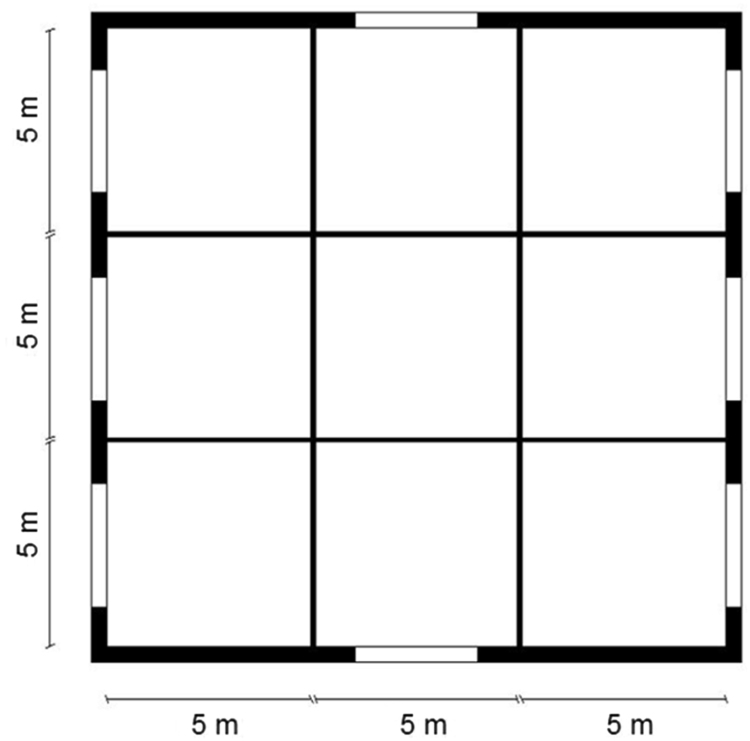
Case study plan.